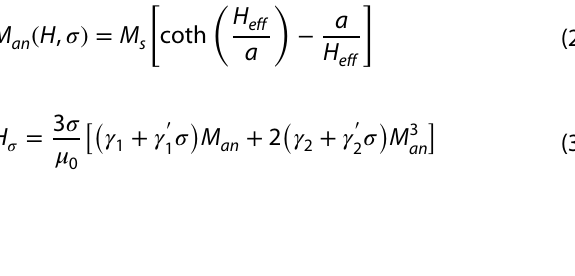
Fig. 1 Variation curves of stress and equivalent stress